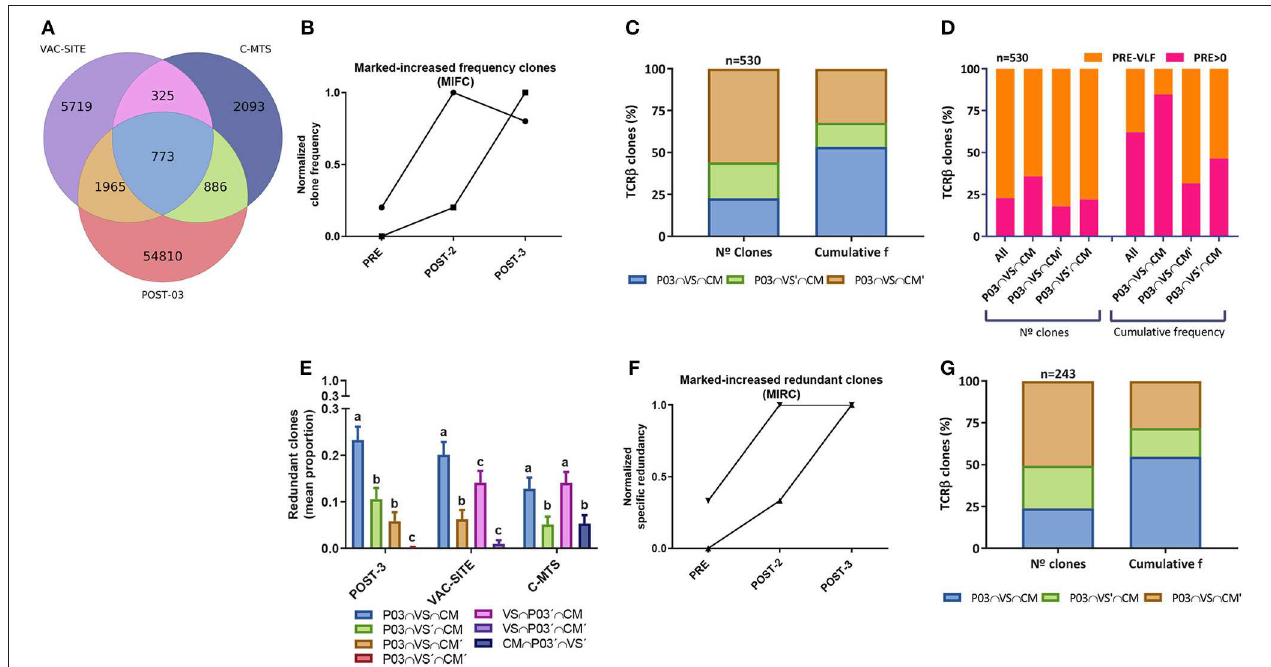
FIGURE 3 | Analysis of in vivo persistent TCR β clones following CSF-470 immunization. (A) Venn diagram showing the distribution of common TCR β clonotypes between PBMC-POST-3, VAC-SITE, and C-MTS samples from pt-045. (B) Normalized frequency tracking of 2 different clonotypes to illustrate markedly-increased frequency clones, MIFC. (C) Distribution (%) of persistent MIFC regarding N ◦ clones and cumulative frequency in the VAC-SITE/C-MTS compartments. (D) Distribution of MIFC and subsets regarding procedence from very-low-frequency clones (PRE-VLF) or basal pre-existing clones (PRE > 0). (E) Mean proportion of redundant clones for each subset within a sample (bootstrap n = 300, 100 iterations); bars with different letters are statistically different (Wilcoxon, p < 0.05). (F) Normalized specific redundancy tracking of 2 different clonotypes to illustrate normalized markedly-increased redundant clones, MIRC. (G) Distribution (%) of persistent MIFC regarding N ◦ clones and cumulative frequency in the VAC-SITE and/or C-MTS compartments. Samples: PBMC-POST-3 = POST-3 = P03; VAC-SITE = VS; C-MTS =